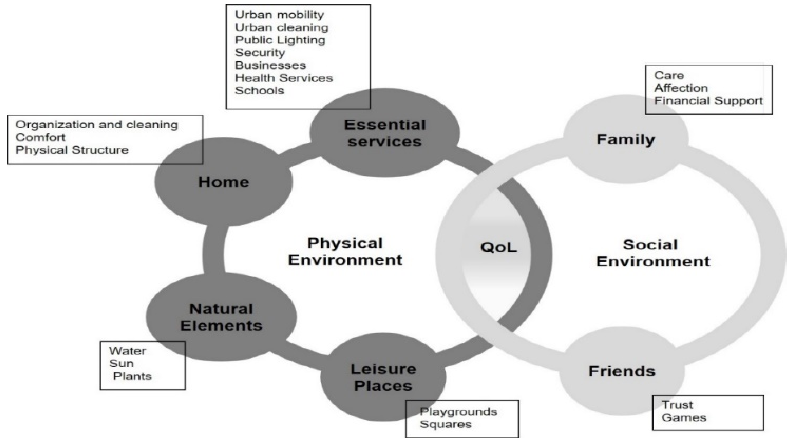
Figure 3. Conceptual Quality of Life (QoL) model for children in their living environment.